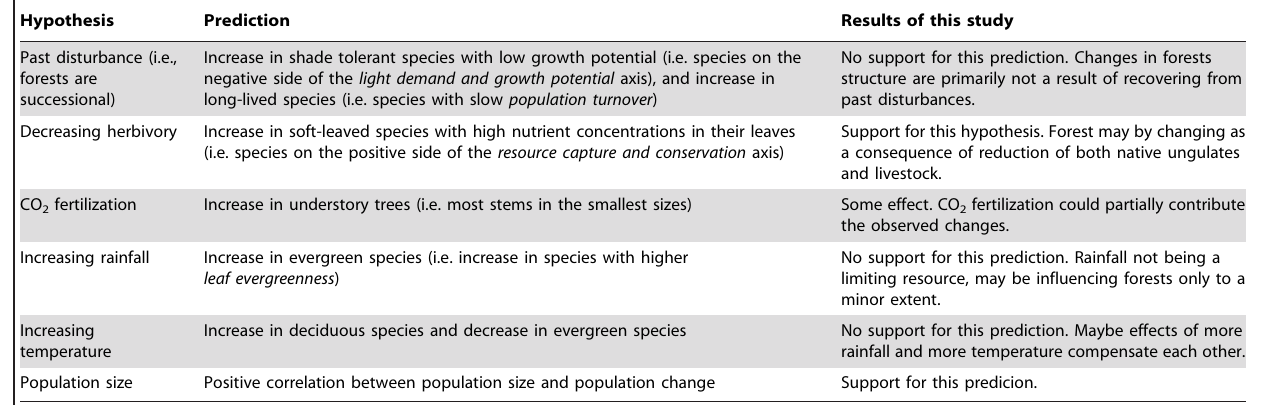
Table 1. Summary of the hypothesis tested in this